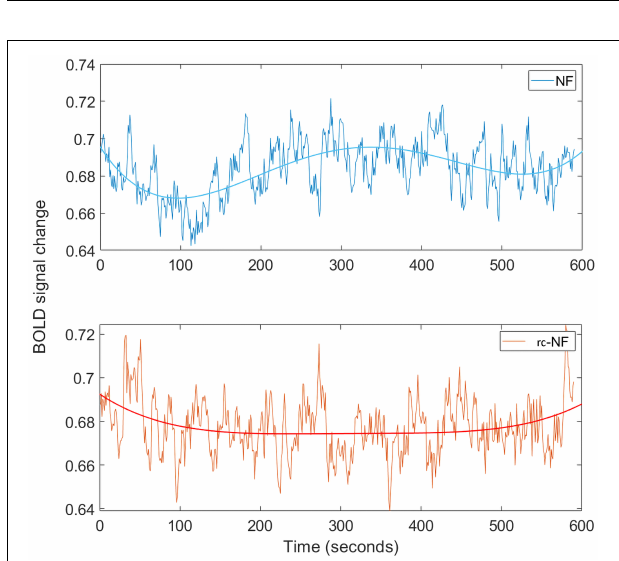
FIGURE 11 | (Top) Averaged BOLD signal for the NF condition throughout the time course. The BOLD signal from our ROI has been processed using the same pipeline as in the rt-fMRI toolbox. (Bottom) Averaged BOLD signal for the rc-NF condition throughout the time course. Fitting applied a fourth-degree